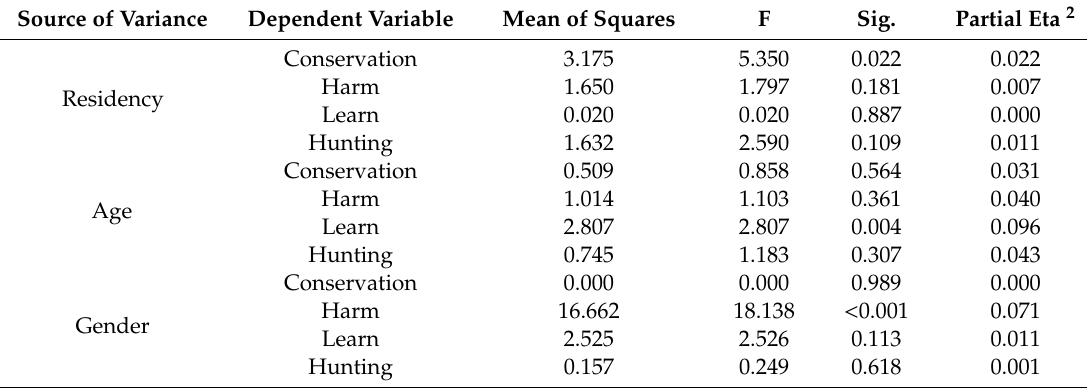
Table 2. Univariate analysis of the dependent variables (subscales) with residency, age, and gender as independent variables. Partial Eta 2 can be understood as the explained variance.